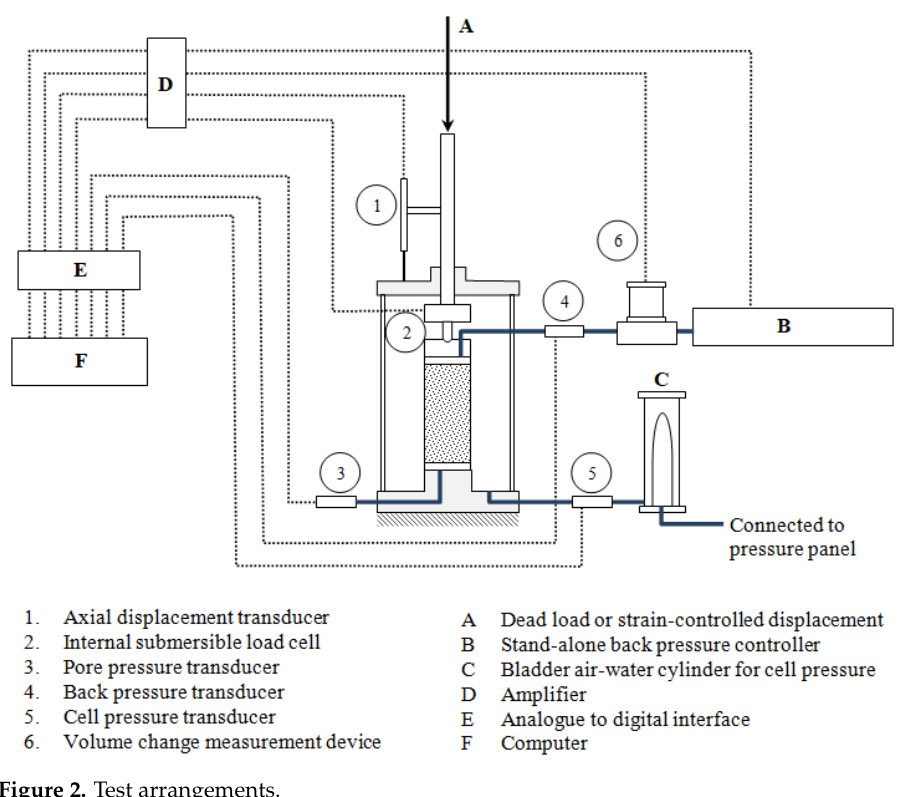
Figure 2. Test arrangements.